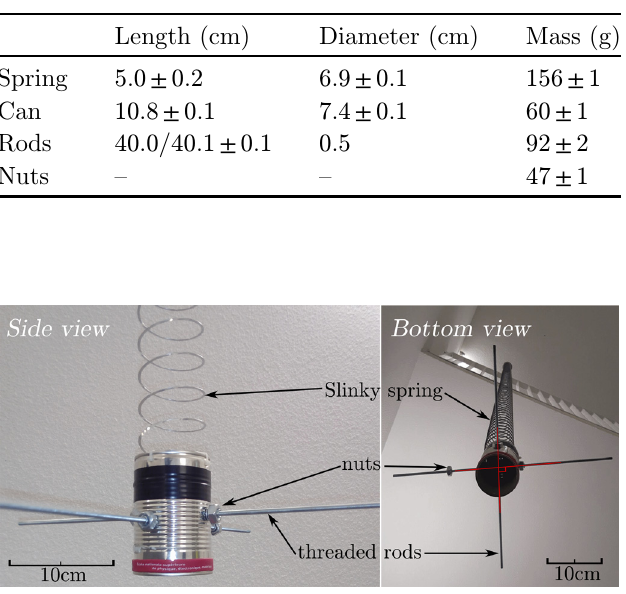
Table 1. Dimensions and masses of all pendulum components. Note that the length of the spring was measured when it was fully compressed.